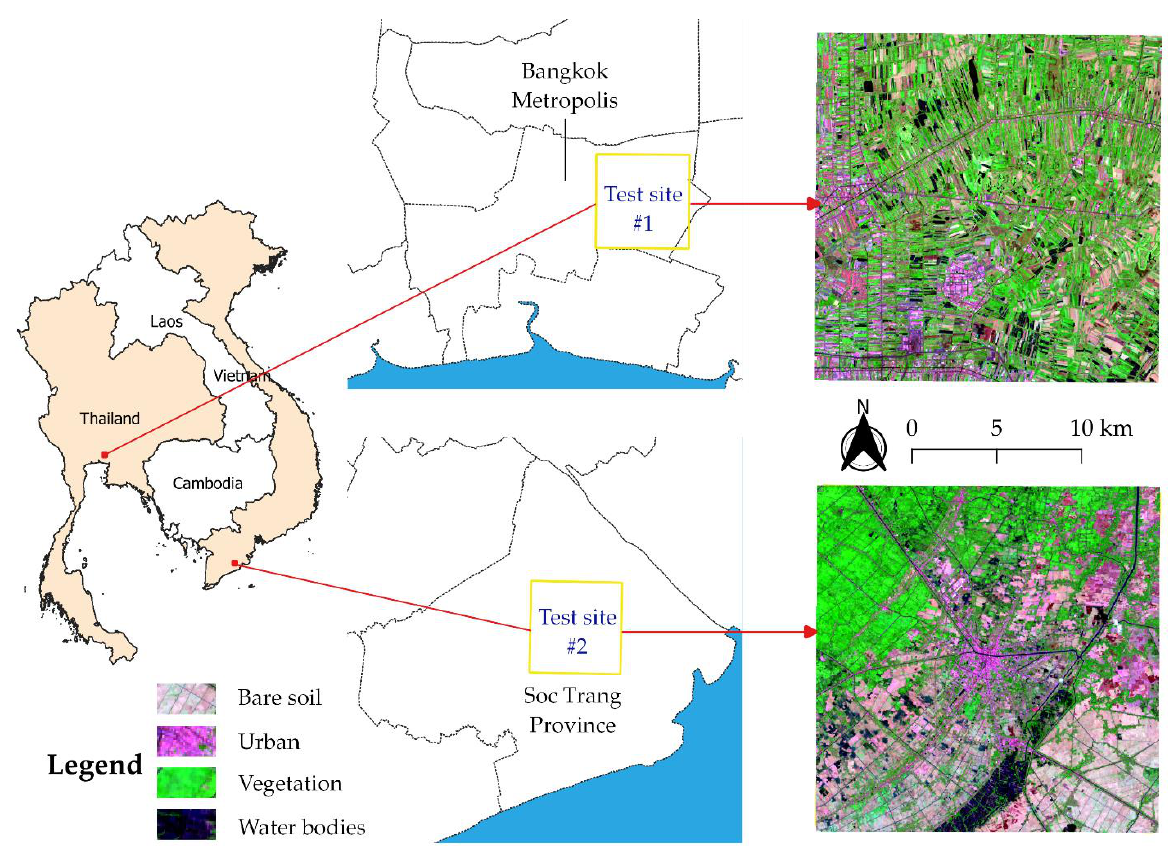
Figure 2. Map of the test sites in eastern Bangkok metropolis (test site #1) and central Soc Trang province (test size #2), false-color composite Landsat 8 (RGB: 7-5-3), pink and prune represent built-up and bare soil.